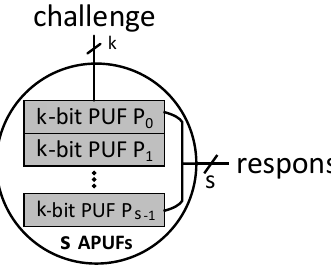
Figure 1. An interconnected physical unclonable functions network (IPN) node of size s and length k . If s = k , the node is homogenous, otherwise it is